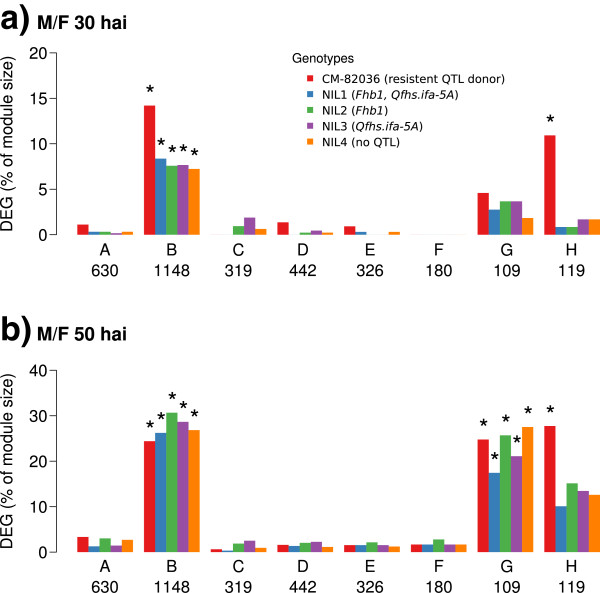
Differentially expressed genes per module. The bar plots indicate the ratio of F. graminearum responsive differentially expressed genes (DEG) per network module for 30 hours after inoculation (hai) (a) and 50 hai (b). To test whether the number of DEG genes was significantly higher than expected by chance we applied a one-sided Fisher’s exact test. Stars indicate a significant enrichment at a Bonferroni adjusted p-value smaller than 0.05.